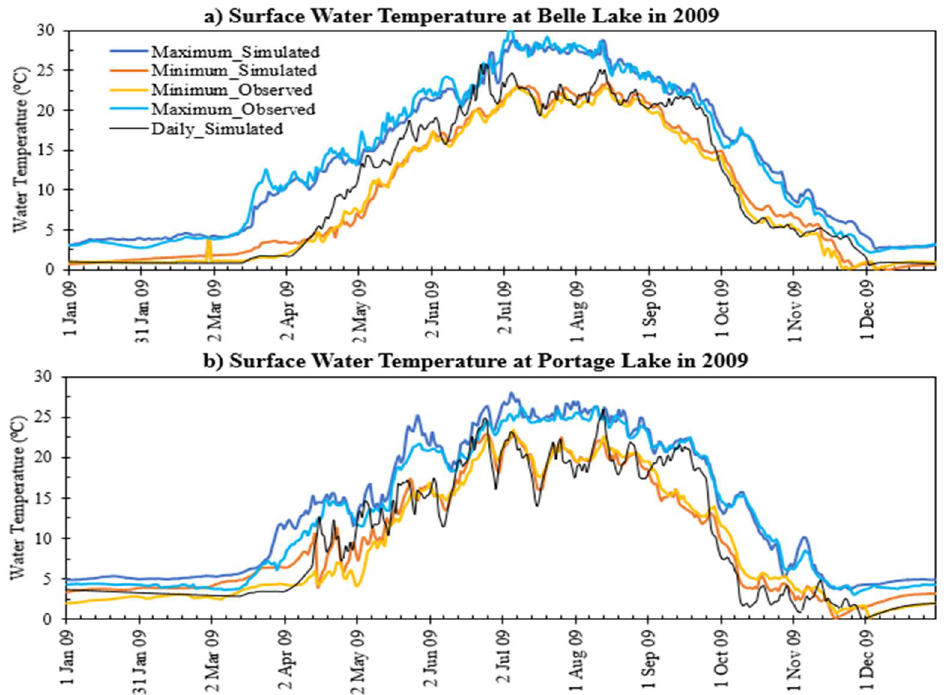
Figure 3. Time series of simulated and observed maximum and minimum hourly surface water temperatures each day at ( a ) Portage Lake and ( b ) Belle Lake in 2009 including simulated daily temperatures.